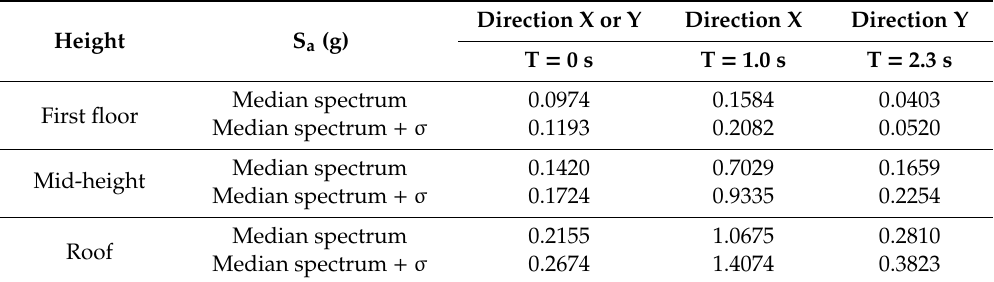
Table 4. Spectral absolute acceleration values for RP = 200 years for three periods of interest. Height